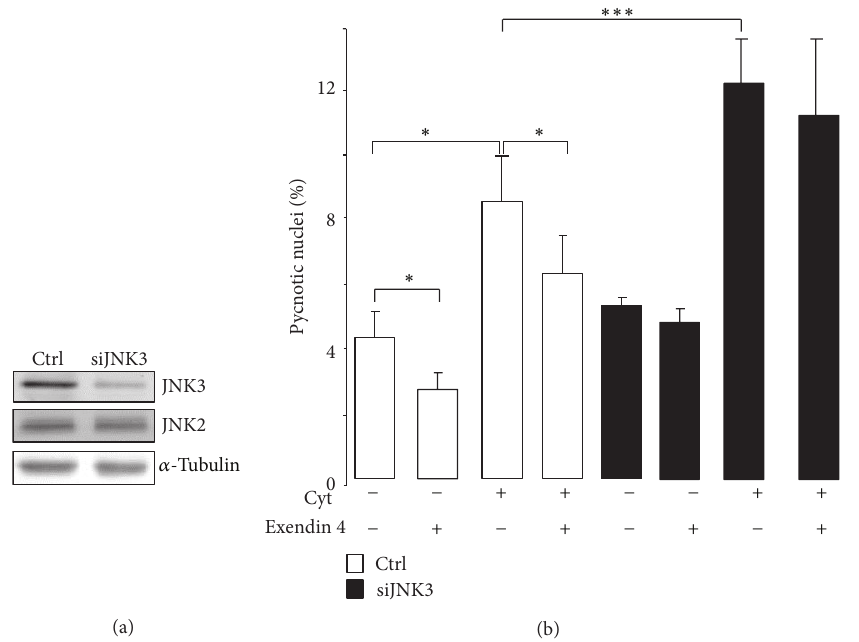
Figure 2: Impact of the JNK3 silencing on the protective effects of exendin 4. INS-1E cells were transfected with the siRNA duplex directed against JNK3 (siJNK3) or control siRNA (siGFP, Ctrl). (a) For western blotting analysis of the JNK3 level, total proteins were prepared 48hr after transfection. Immunoblotting was done using the anti-JNK3, anti-JNK2, and anti- 𝛼 -tubulin antibodies (b) for scoring death; the cells were preincubated 24 hr after transfection with 50 nM exendin 4 for 8 hr. The rate of apoptosis was scored by counting pycnotic nuclei in INS- 1E cells exposed for 16 hr to the cocktail of cytokines including 10ng/mL IL-1 𝛽 , 15ng/mL TNF 𝛼 , and 150 ng/mL IFN 𝛾 . Results are expressed as mean ± SEM of 3 independent experiments. ∗ 𝑃 < 0.05 ; ∗∗∗ 𝑃 < 0.001